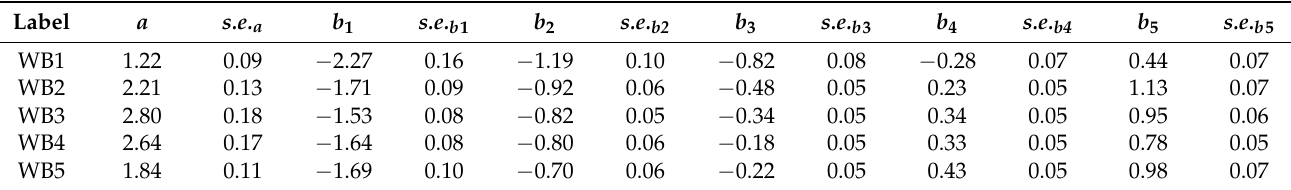
Table 3. Graded Model Item Parameter Estimates, logit: a ( θ - b ).